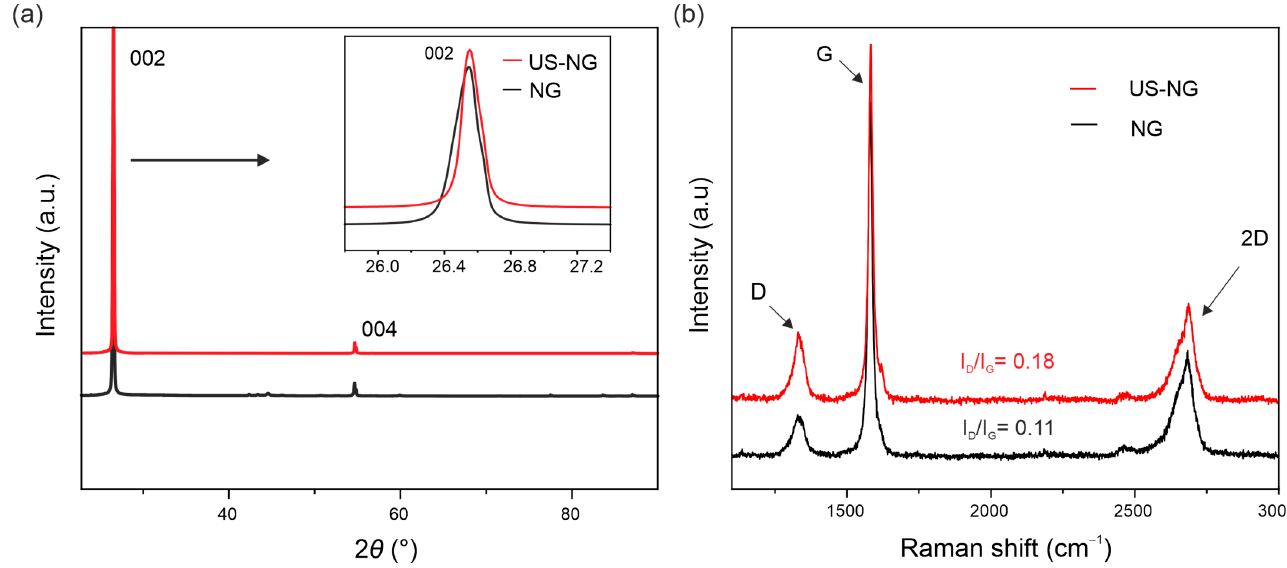
Figure 1. Structural characterization: ( a ) XRD and ( b ) Raman spectra of NG (black curves) and US-NG (red curves). Table 1. Quantification of structural parameters of NG and US-NG from XRD and Raman spectroscopy.